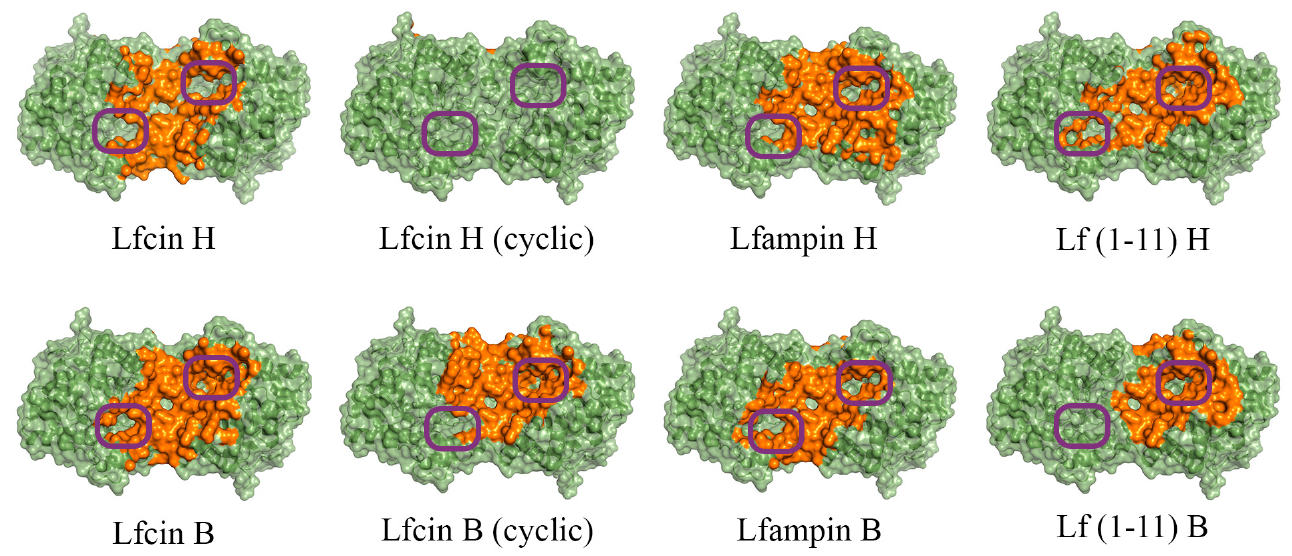
Figure 2. Front view of domains for binding of human (H) and bovine (B) lactoferrin-derived AMPs at pH 10.5 on the surface of His 6 -OPH homodimer (colored green). The atoms located within 4 Å of any AMP atom and the corresponding molecular surface are colored orange. The entrances to the active sites of His 6 -OPH dimer are highlighted with purple boxes.